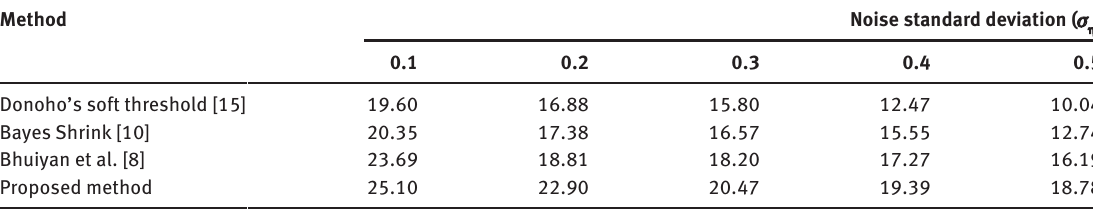
Table 6: Comparison of SNR (dB) Performance for MR